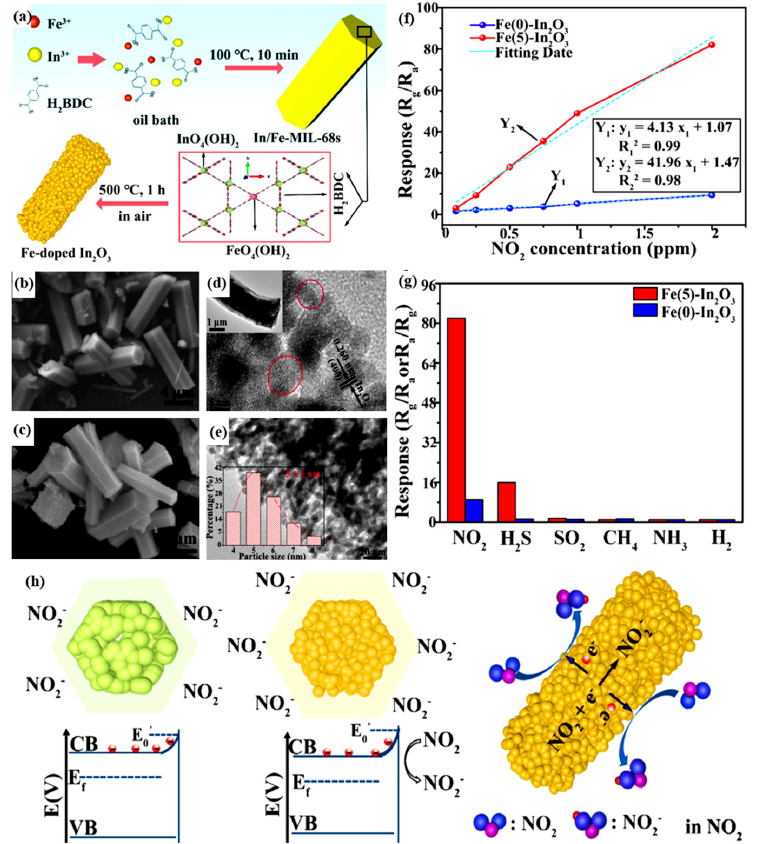
Figure 2. ( a ) Synthetic process of the mesoporous Fe-doped In 2 O 3 nanorods derived from In/Fe-MIL- 68s; SEM images of ( b ) In/Fe-MIL-68s precursor with 5 mol.% Fe(III) content and ( c ) as-resulted